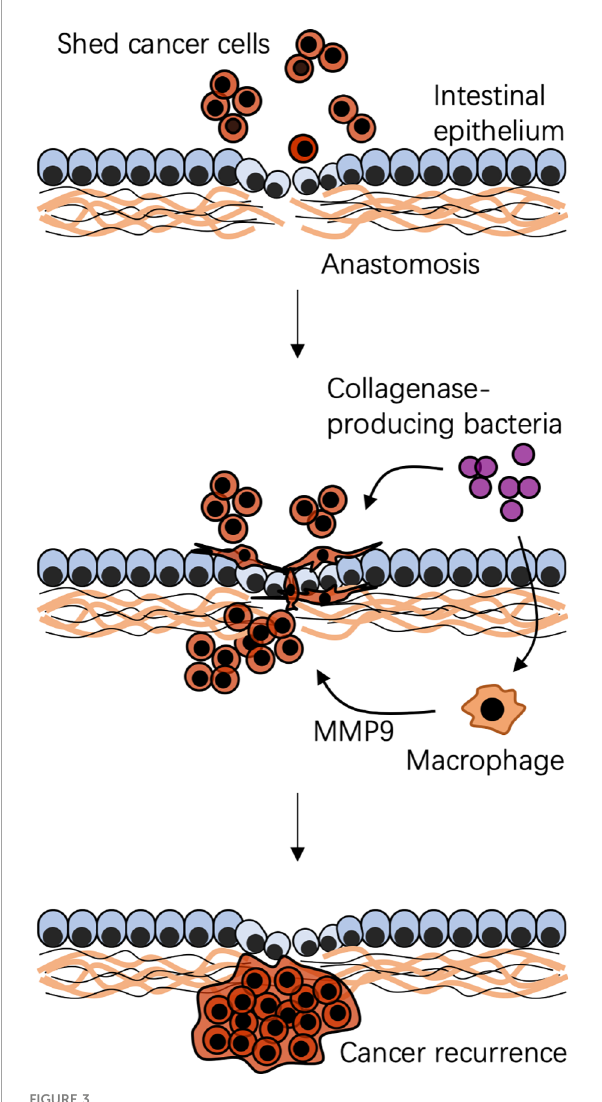
FIGURE 3 Possible mechanism of bacteria-associated colorectal cancer recurrence after surgical resection. A speci fi c local context is created by surgical resection and reconstruction. Shed cancer cells occur during and after surgery. Context-dependent colonization of collagenase-producing bacteria, such as Enterococcus faecalis , cooperating with local macrophages, impairs anastomotic healing and promotes shed cancer cell proliferation, migration, and invasion, leading to cancer recurrence. MMP9, matrix metalloproteinase